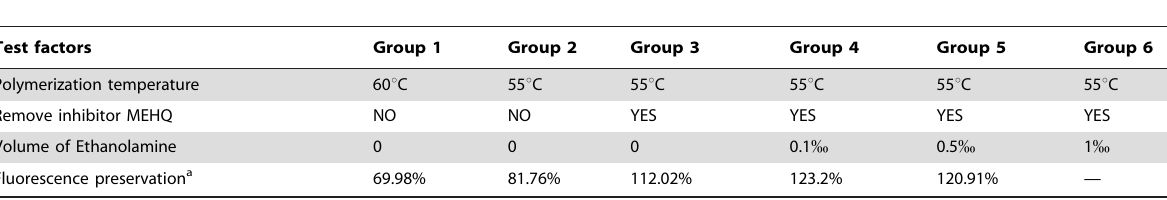
Table 3. Different formulation of GMA and its fluorescence preservation.